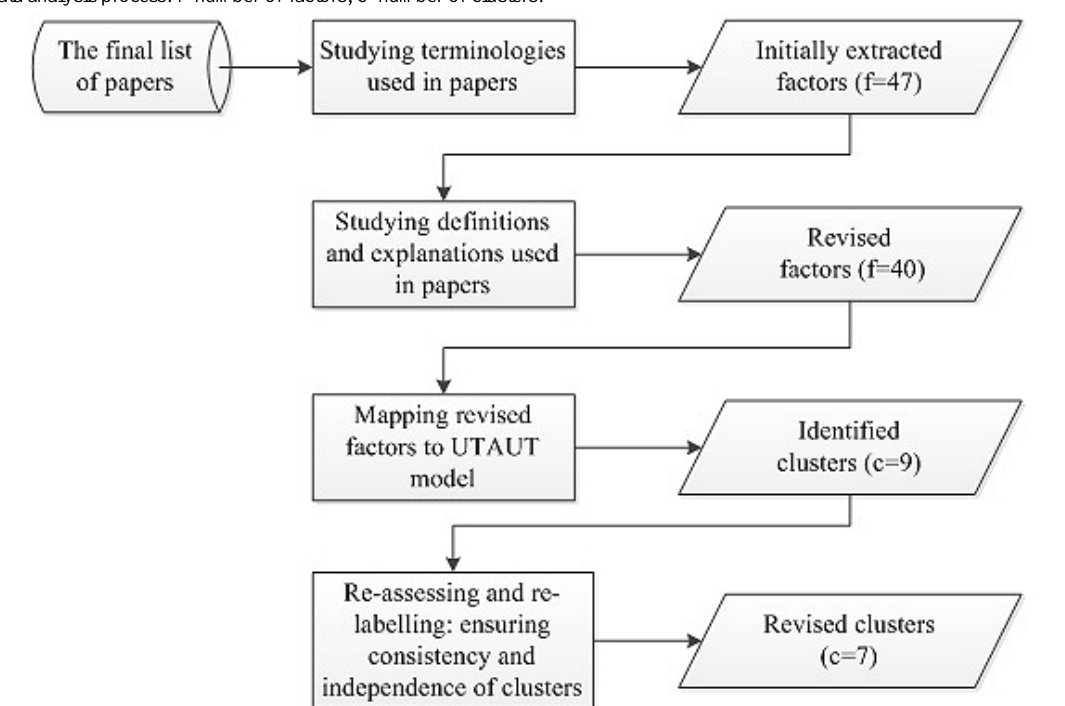
Figure 1. Data analysis process. f=number of factors; c=number of